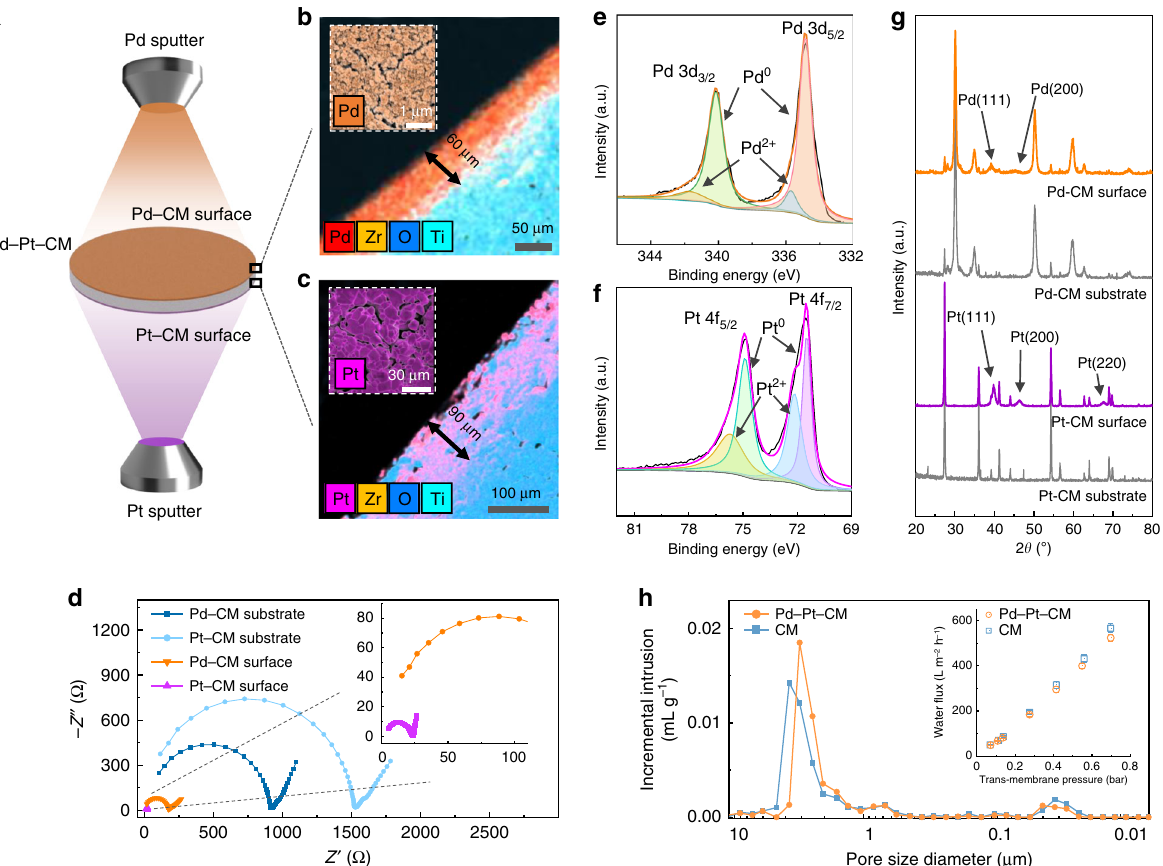
Fig. 1 Fabrication and characterization of the Pd – Pt – CM. a Schematic depicting the fabrication of the Pd – Pt – CM by magnetron sputtering. b , c SEM cross- section images of the Pd – CM and Pt – CM surfaces, overlapped with EDS mapping of Zr (yellow), O (blue), Ti (green), and Pd (red) or Pt (purple) elements. The insets illustrate the SEM surface images of the respective functionalized membranes overlapped with EDS mapping of Pd (orange) or Pt (purple) element. d Nyquist plots of the Pd – CM and Pt – CM surfaces of the Pd – Pt – CM and corresponding CM substrates in 100 mM Na 2 SO 4 solution at applied frequencies varied from 10 6 – 1 Hz. e , f XPS spectra of the Pd 3d and Pt 4f on the Pd – Pt – CM, respectively. g Grazing incidence XRD patterns of the Pd – CM and Pt – CM surfaces of the Pd – Pt – CM with their respective CM substrates. h Pore size distributions of the Pd – Pt – CM (orange circles) and the pristine CM (blue squares). The inset shows the water fl uxes of the Pd – Pt – CM and the pristine CM as a function of transmembrane pressure (error bars represent standard deviation from triplicate spectroscopy (XPS) and the grazing incidence X-ray diffraction (GI-